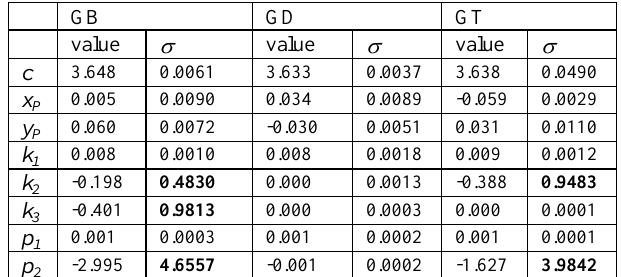
Table 5: Interior Orientation parameters of all three cameras using the 12MB shake test series (in